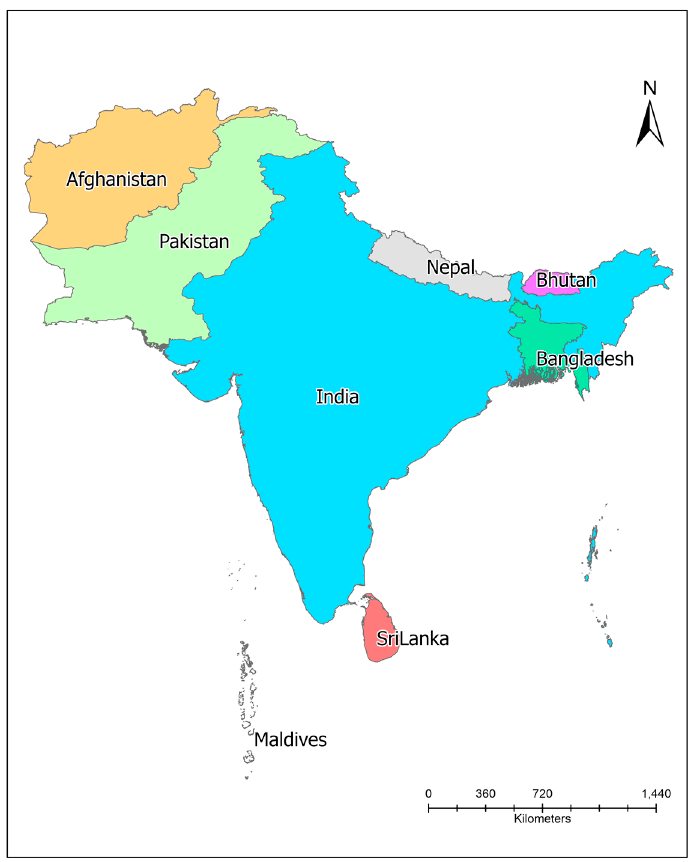
Figure 1. Map of South Asia (data source: https://www.diva-gis.org/gdata (accessed on 12 July 2021) and Survey Department, Nepal) .